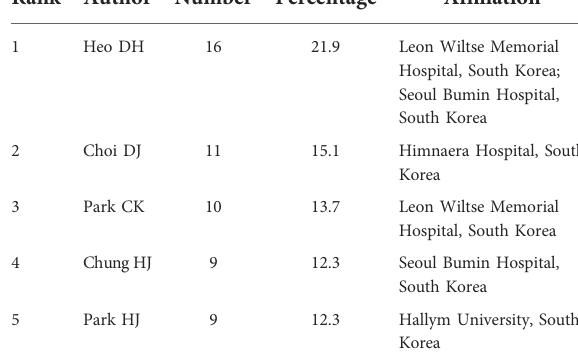
TABLE 2 The most productive institutions in the fi eld of unilateral biportal endoscopic spine surgery. Rank